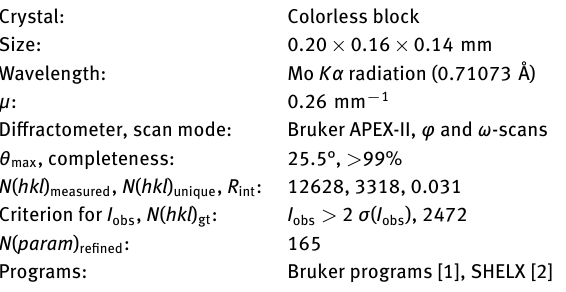
Table 1: Data collection and handling.